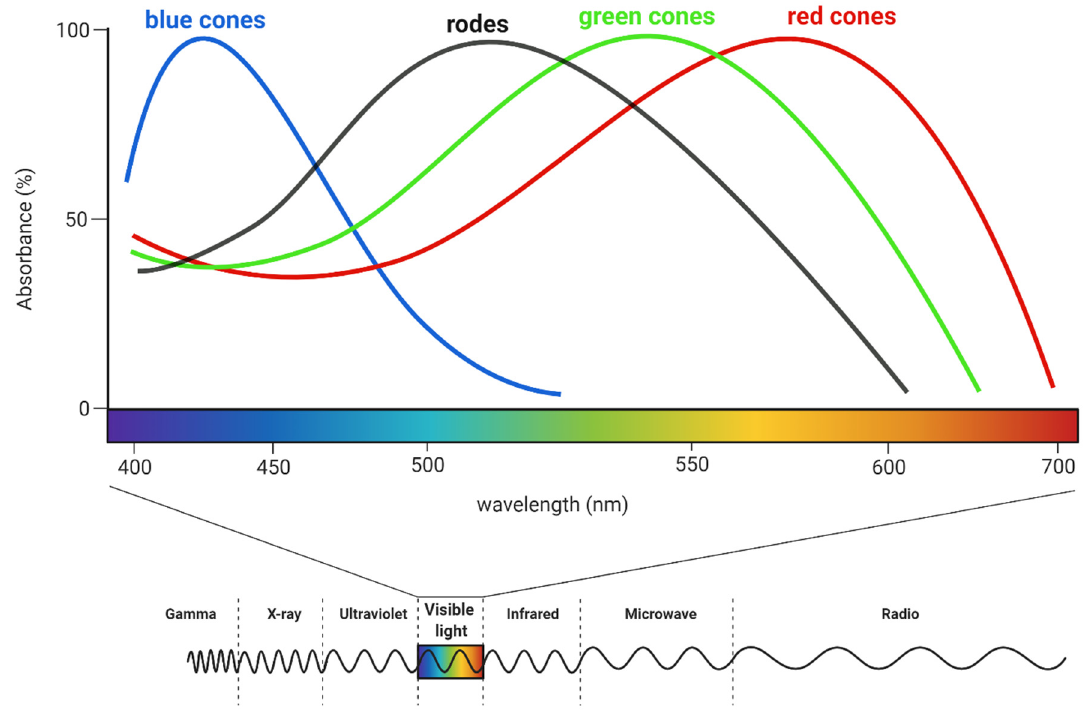
Figure 4. The sensitivity of rods and cones on different light wavelengths. Humans can perceive electromagnetic waves with a length of about 350–700 nm. For comparison, gamma-ray waves have a length less than 10 − 12 m, while radio waves are longer than 1 mm. Created with